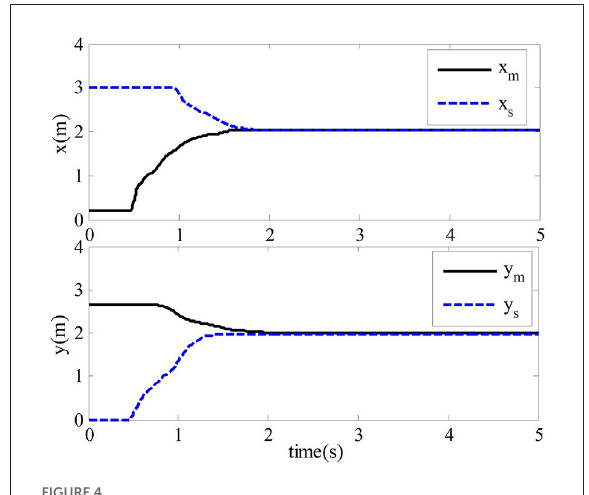
FIGURE4 Trajectory map of end position tracking.